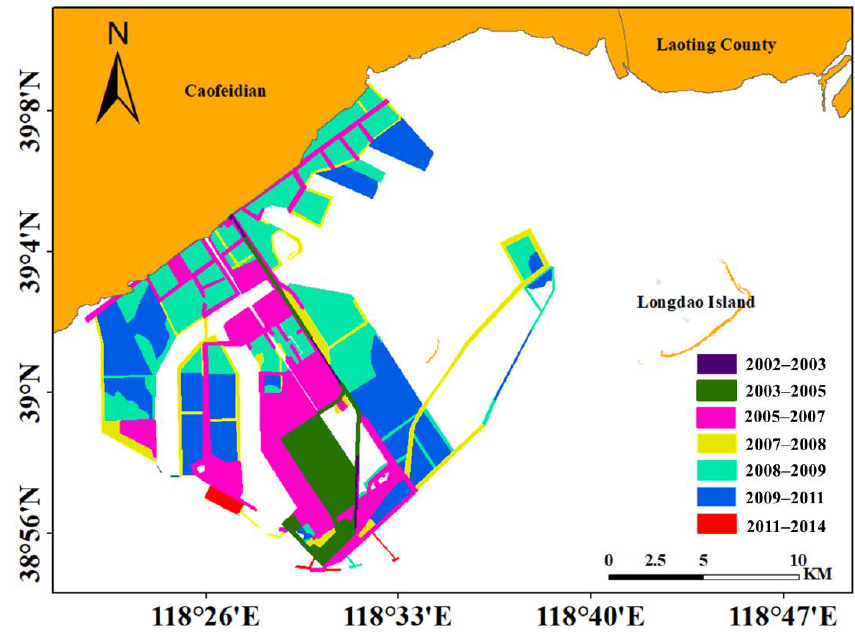
Figure 10. Spatial-temporal distribution of land reclamation in the study area from 2002 to 2014.